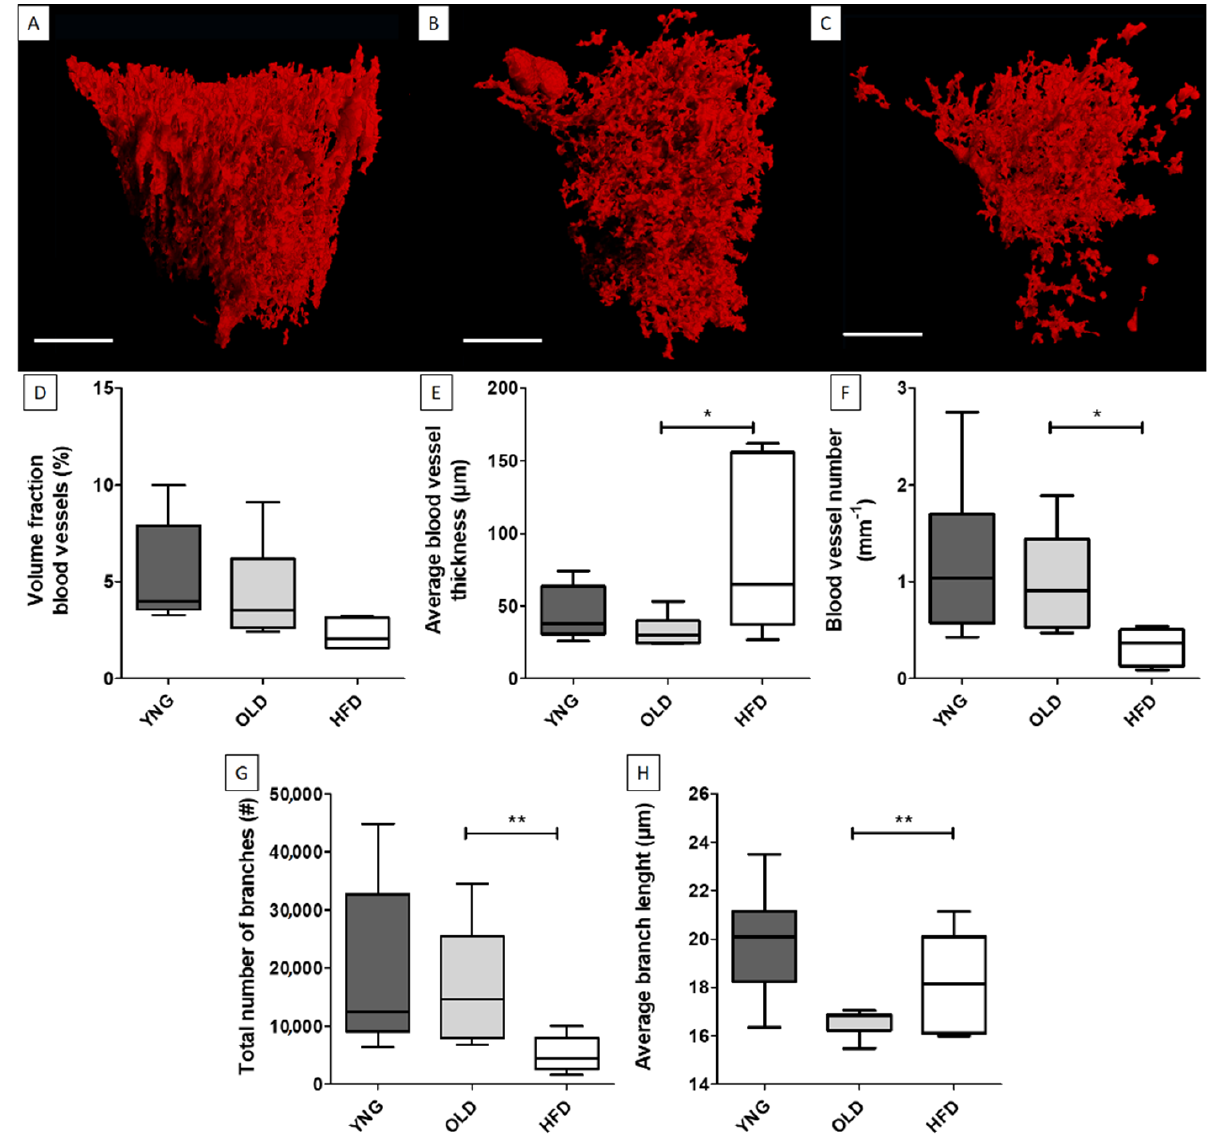
Figure 6. Bone marrow vasculature of the tibial metaphysis stained with Hf-WD POM. ( A ) Young (YNG), ( B ) old and ( C ) high-fat diet mice (HFD). Scale bars represent 250 µm. Quantification of the ( D ) volume fraction of the blood vessels in the medular open volume, ( E ) average blood vessel thickness, ( F ) blood vessel density, ( G ) total number of branches and ( H ) average branch length. * p < 0.05; ** p < 0.01 (adapted from and with kind permission from Reference [78] with permission from Elsevier).